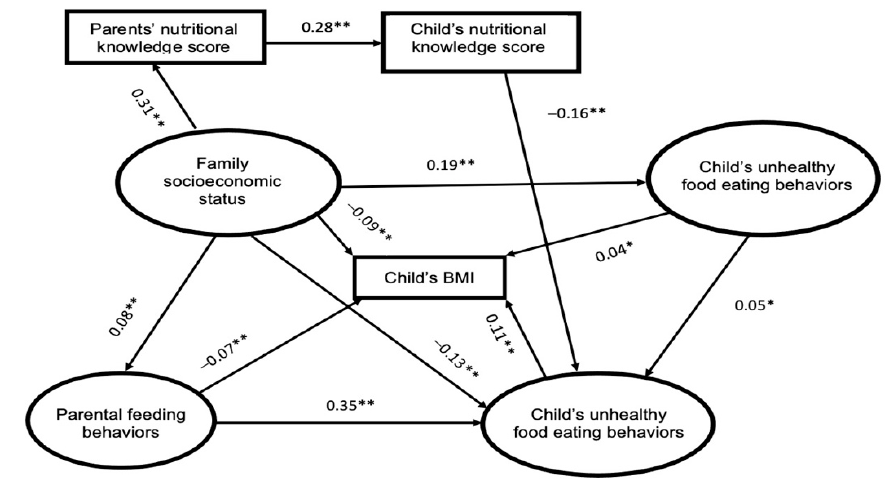
Figure 3. Model B (the solid line represents statistically significant values. * p < 0.05; ** p < 0.0001).